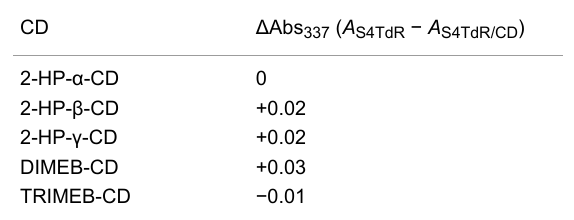
Table 1: Absorbance variation of S 4 TdR when CDs were added at a molar ratio of S 4 TdR/CD = 1:1. Δ Abs 337 was obtained reading the ab- sorbance value, at 337 nm, of the solution containing S 4 TdR in absence and in presence of